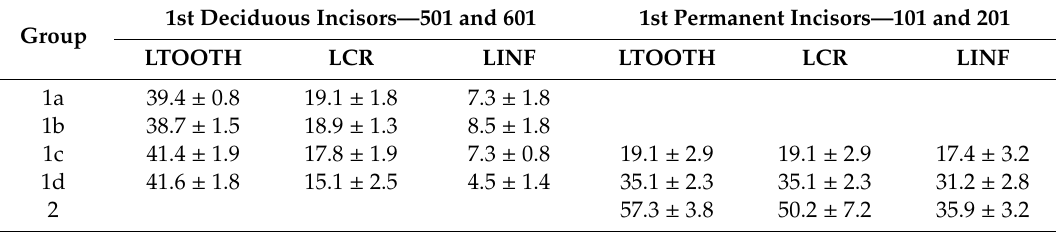
LTOOTH: Length of the tooth, LCR: Length of the crown, LINF: Length of the